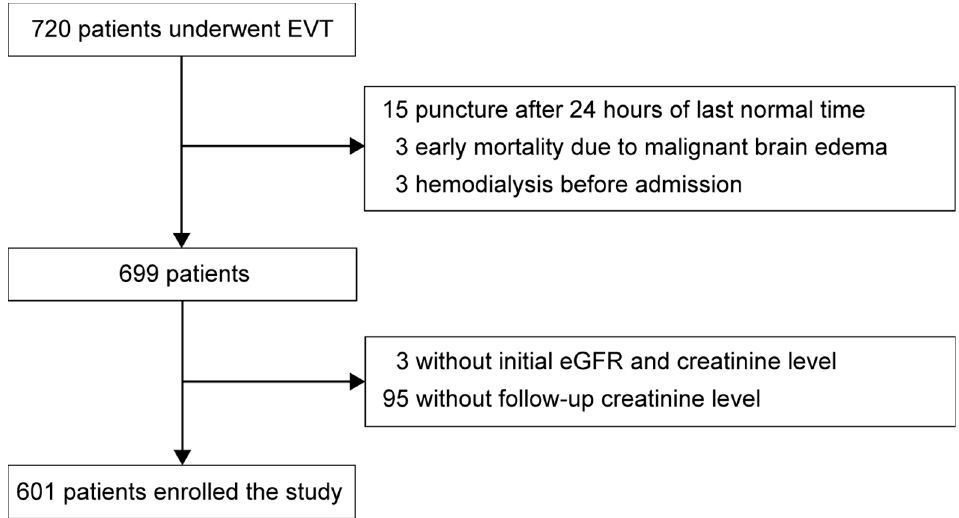
Figure 1. Patients enrollment. EVT, endovascular treatment; eGFR, estimated glomerular filtration rate.